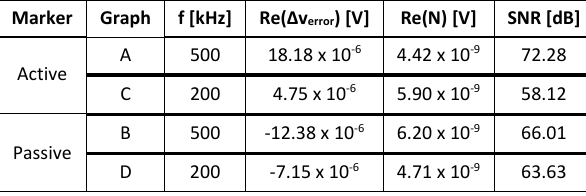
Table 3: Some quantitative data on the detection signals Re(Δ v error ) in figure (7).